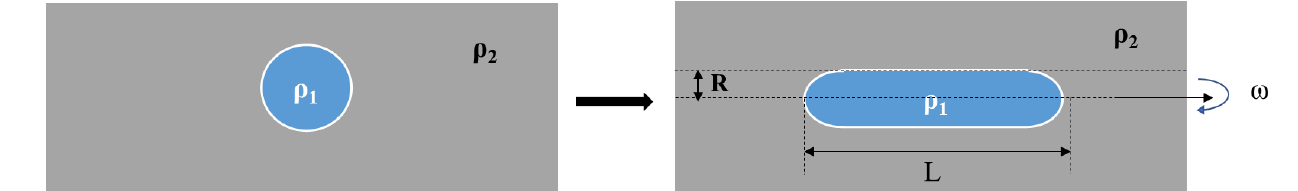
Figure 27. Schematic diagram of the spinning drop principle. This method was developed by Vonnegut [84]. The interfacial tension can be de- termined if the drop length is at least four times longer than the drop radius: L > 4R (Equation